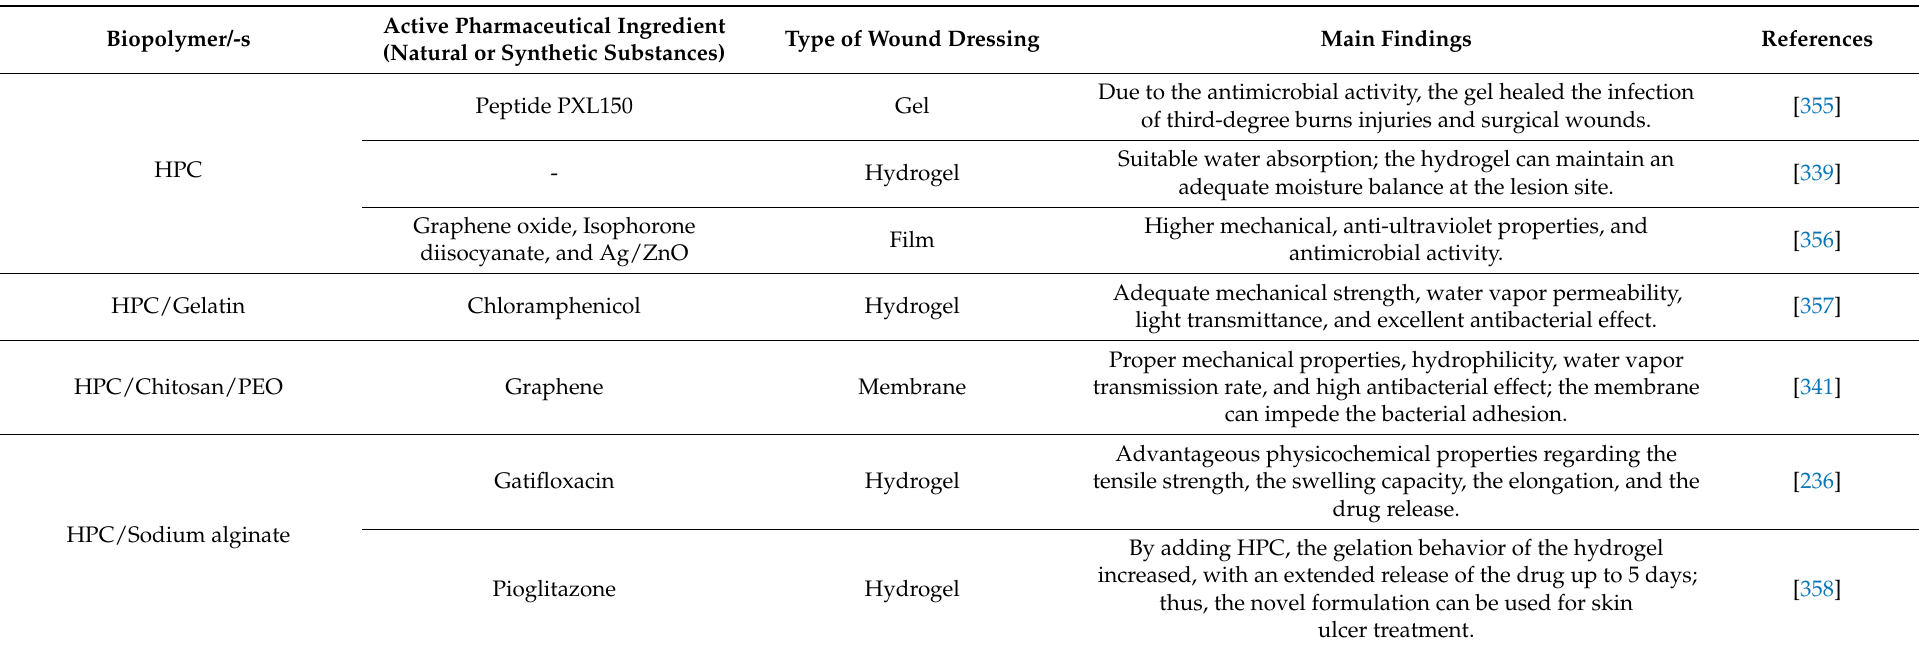
Table 8. Recent studies on the use of hydroxypropylcellulose as a wound